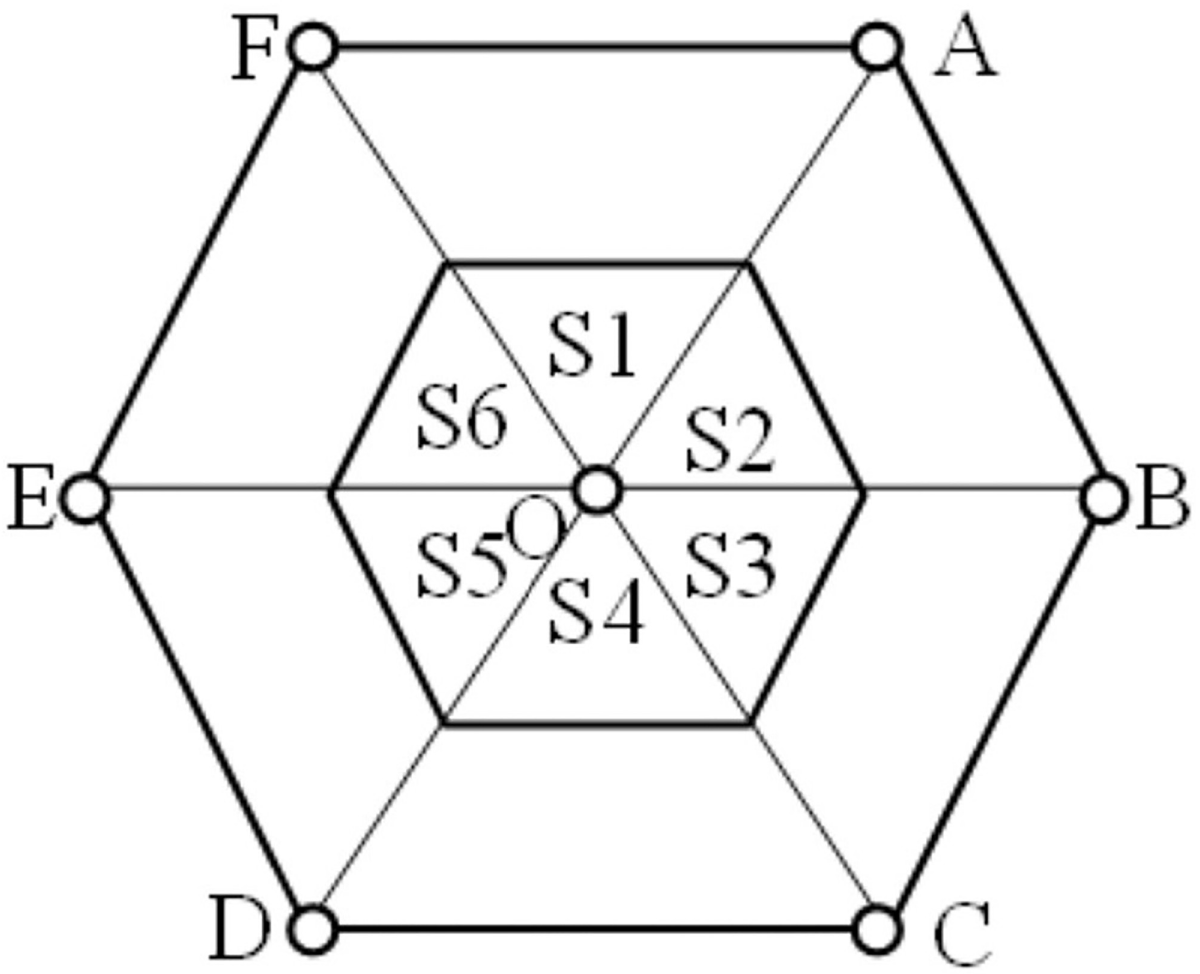
Fig 7. Five BSs selection regional